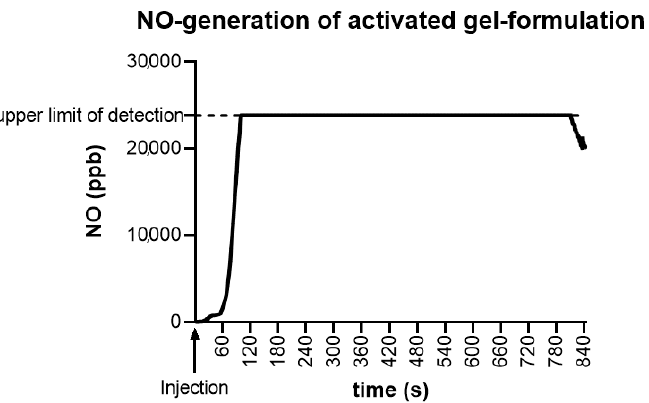
Figure 1. Nitric oxide (NO)-generation of activated gel-formulation. In vitro mixture of 1 cm 3 of each component resulted in stable generation of NO, exceeding the upper limit of detection of 23.847 ppb NO, resulting in a plateau phase of >15 min after activation time of approximately 60 s.